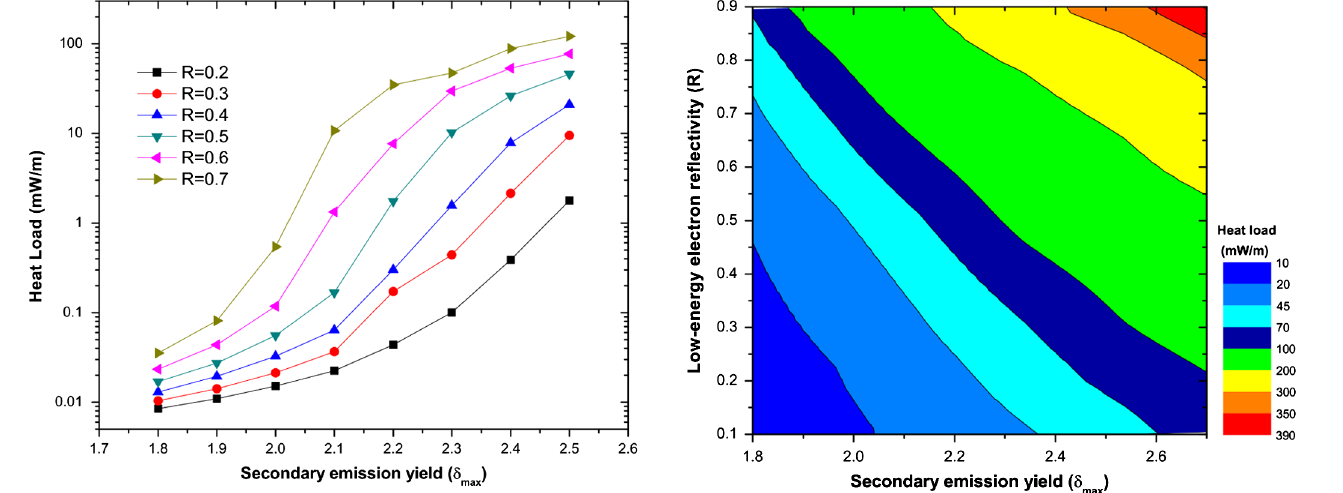
FIG. 8. Simulated average arc heat load for 50 ns bunch spacing at injection energy. Bunch population: 1 : 1 (cid:2) 10 11 ppb . During the corresponding experiment, an average heat load of about 20 mW = m was measured.